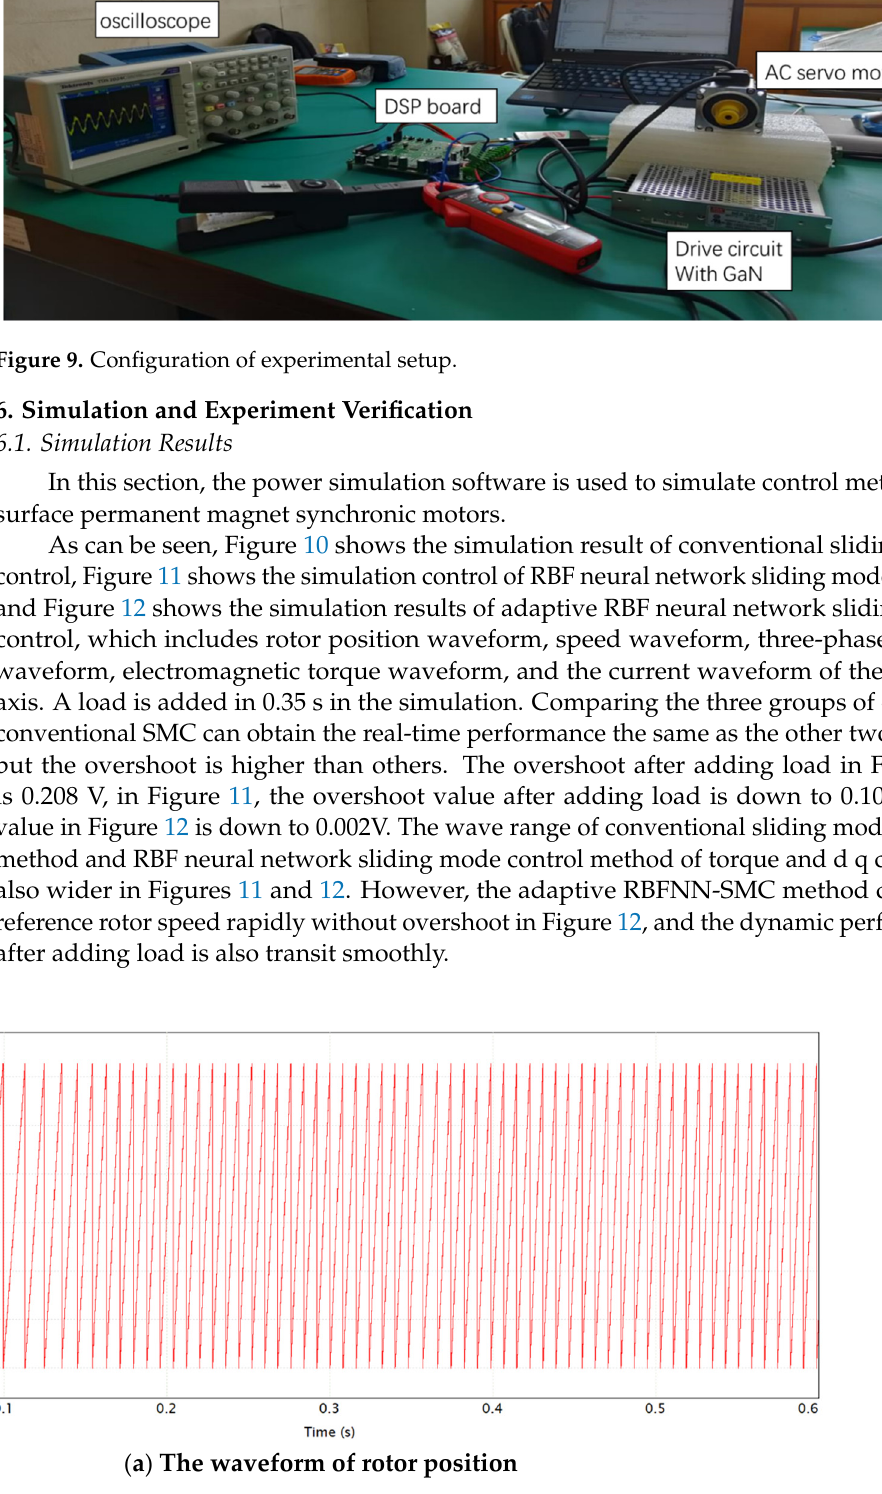
( a ) The waveform of rotor position Figure 10. Cont